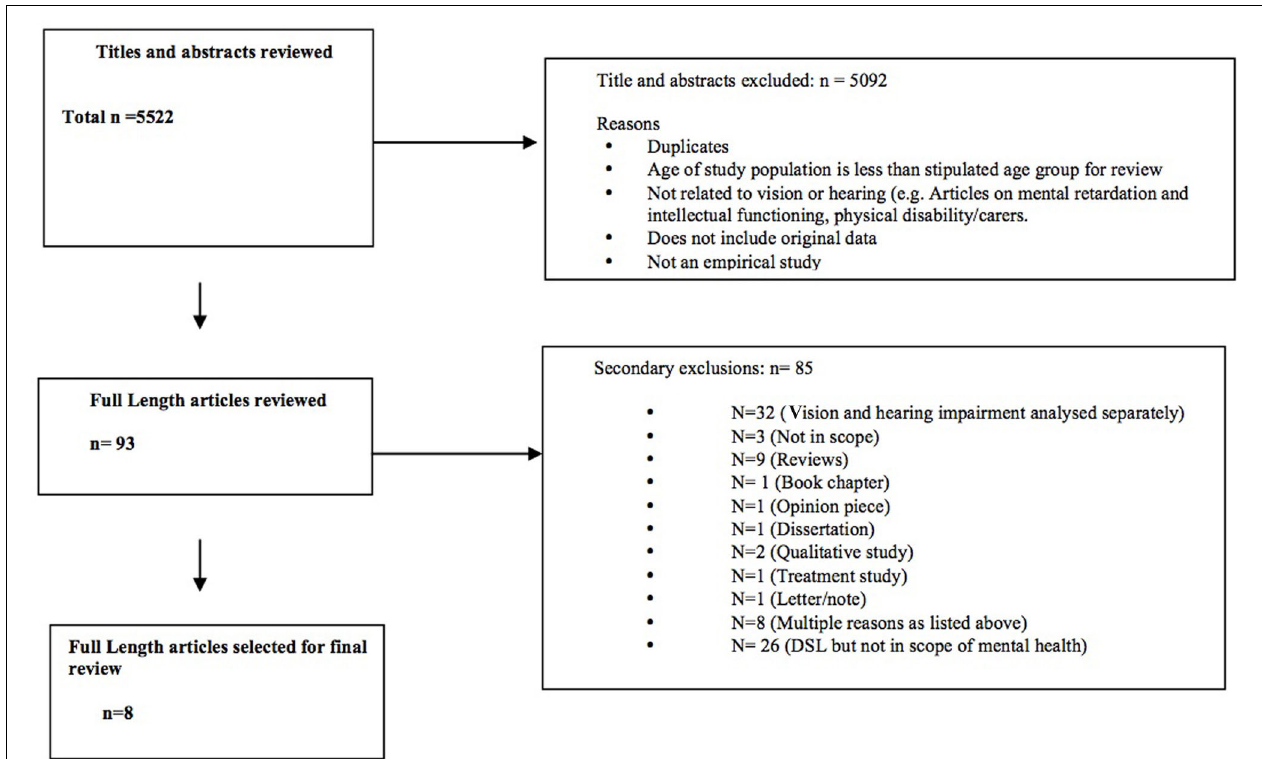
FIGURE 1 | Article selection